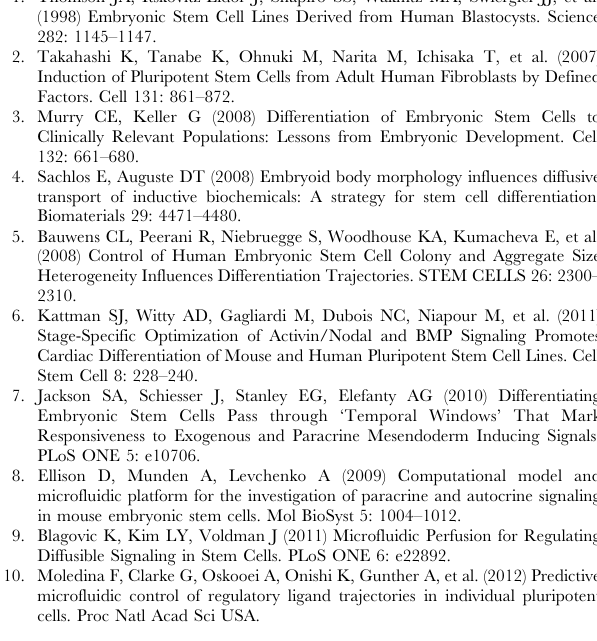
Figure S5 Array run for 3.5 d. ( a ) Confocal tile scan images of HES3( MIXL1 GFP/w ) hESCs expressing GFP and counterstained with Hoechst 33342 at 3.5 d experiment endpoint. Similar